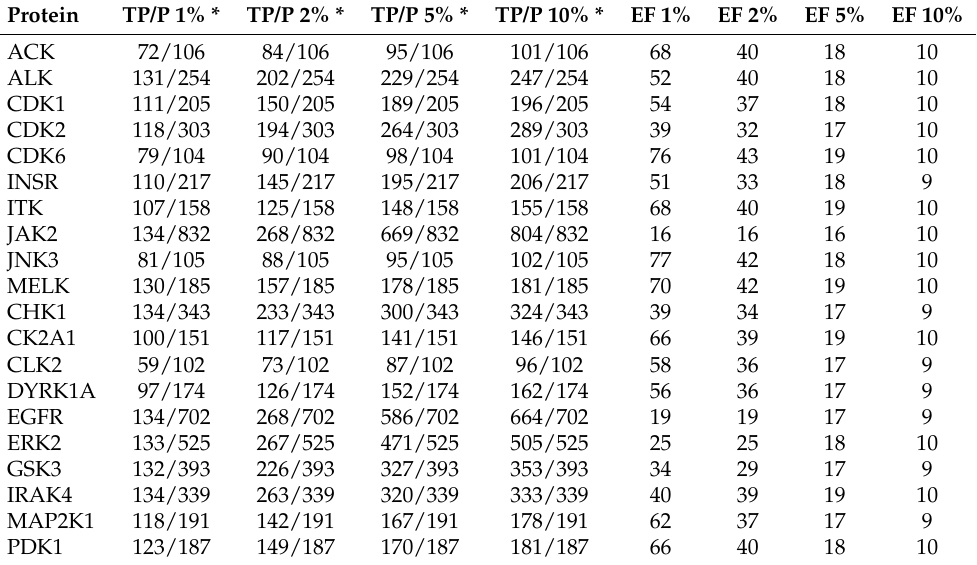
Table 2. True Positives versus Positives ratio and Enrichment Factors computed on the entire test